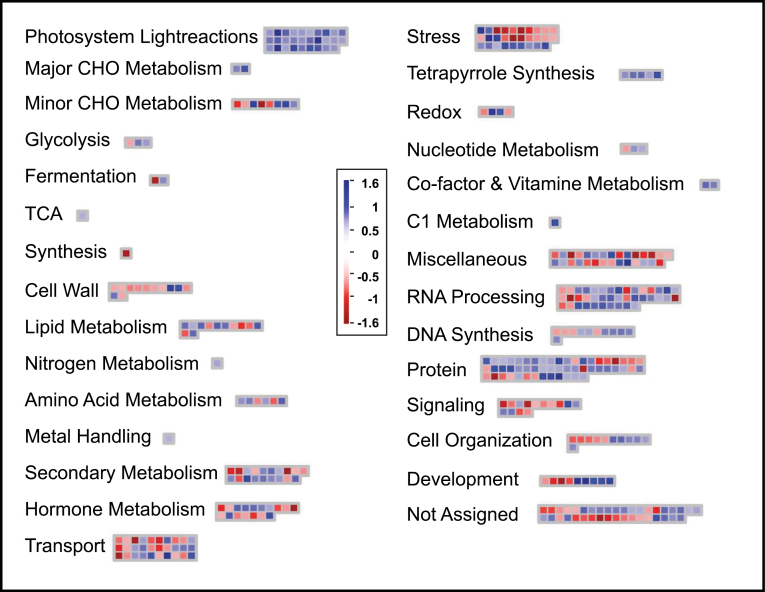
Functional categorization of transcripts found to be up- or downregulated during chilling (≤14 °C) in Miscanthus × giganteus. Functional groups are as categorized by MapMan (Usadel et al. 2009). Red boxes indicate downregulated transcripts and blue boxes represent upregulated transcripts, as indicated by the scale from –1.6 to 1.6 log2 fold-change in expression. See Table 2 for numerical details of the change in each transcript.